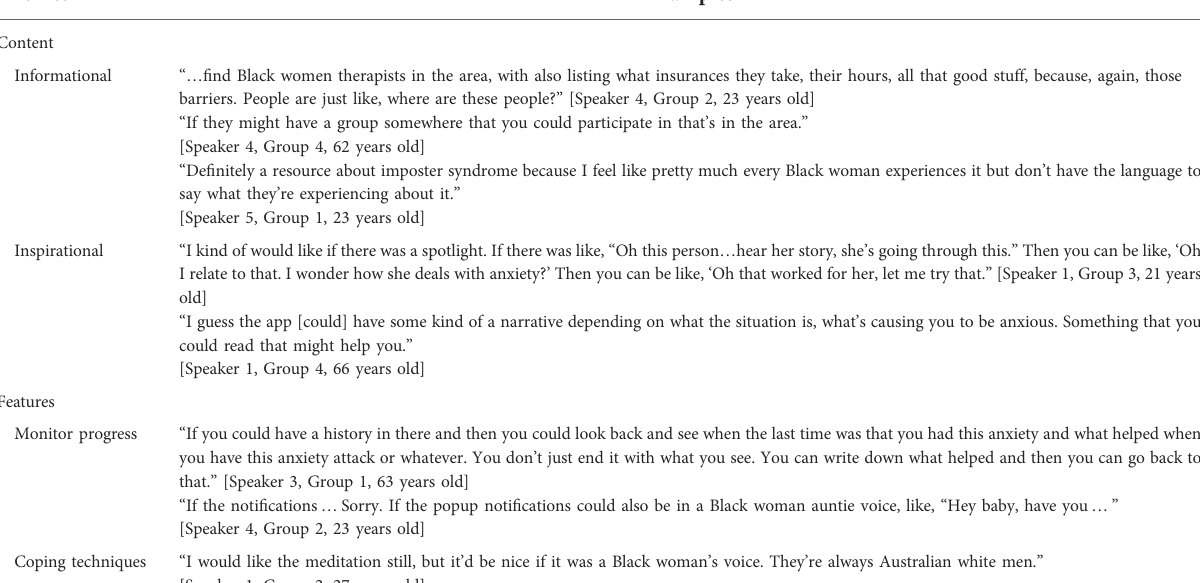
TABLE 1 Supporting quotes for recommendations on design of a mobile app to support management of anxiety and depression among Black women.